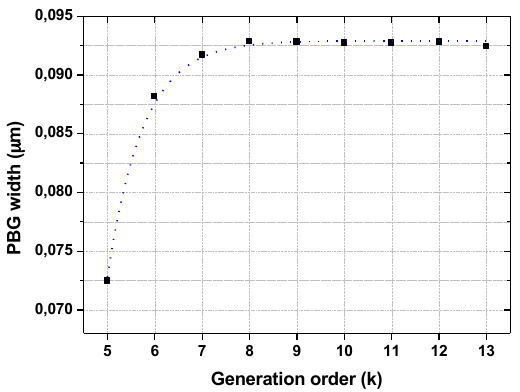
Figure 5: Evolution of BPG width (around λ according to the generation order (k) of the Period- Doubling sequence For a dielectric multi-layer system according to the Period- Doubling distribution, the transmission spectra (Fig. 4) shows the presence of a photonic band gap centred around λ =0.5 µ m. The PBG width increases exponentially 0 (Fig. 5) as a function of the iteration (k). It is also noticed that for large values of the generation order (k) (starting from the 8 th iteration), we see the presence of multitudes of